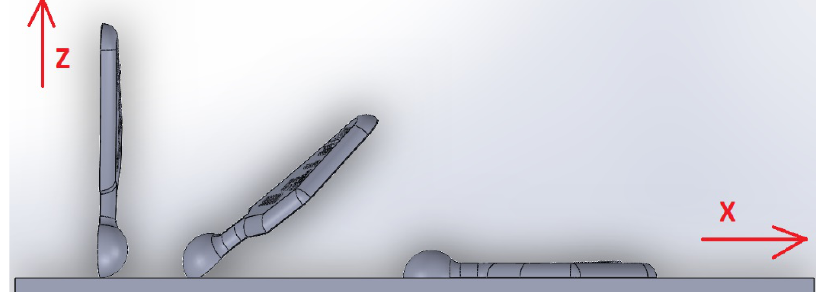
Figure 3. Visualization of 3D printer platform.